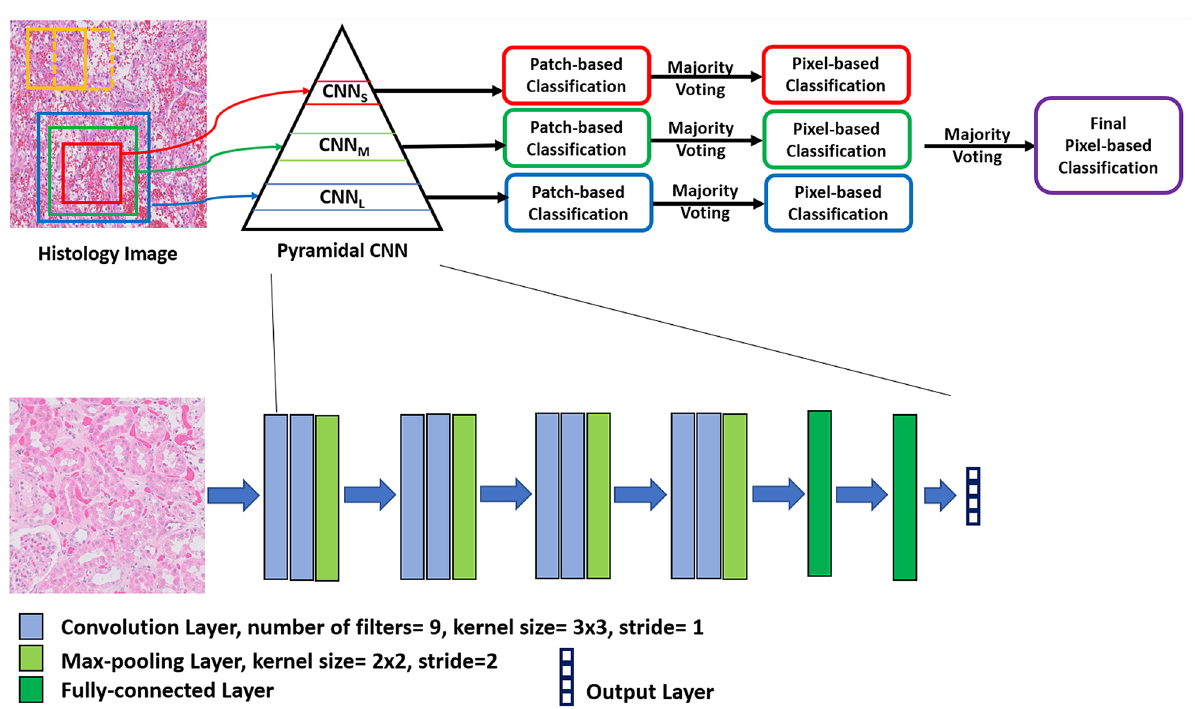
Figure 4. The pyramidal deep learning framework which consists of three convolutional networks for the automated classification of kidney histopathological